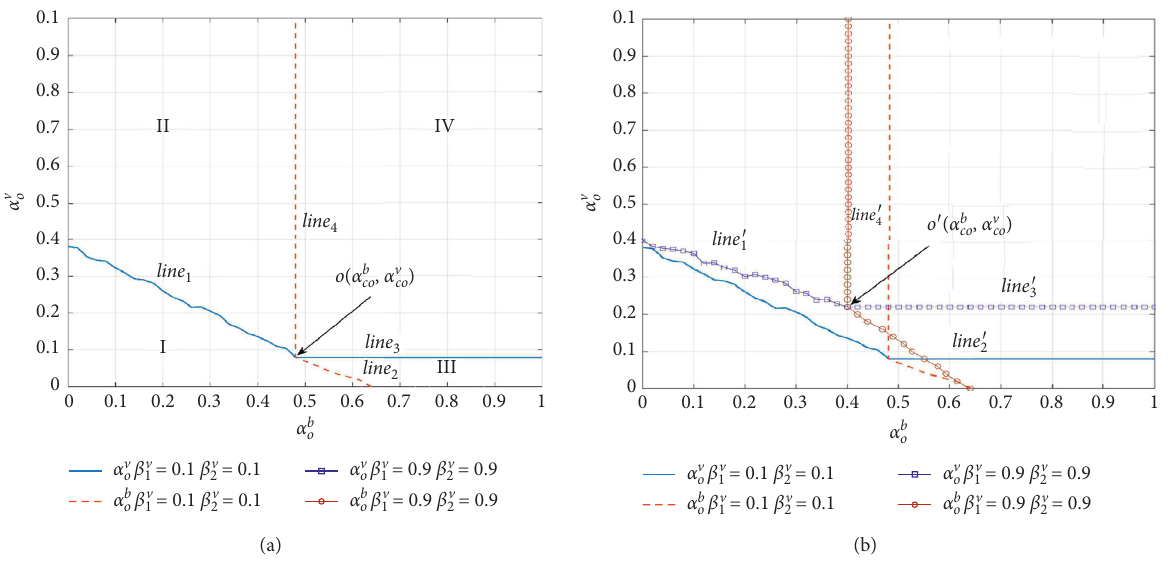
Figure 7: Phase diagram of vehicle and bicycle critical inflow